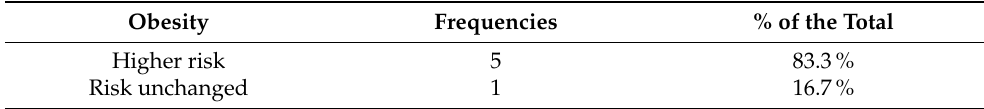
Table 2. Articles grouped by findings concerning obesity as a risk factor for biological complications of dental implants.